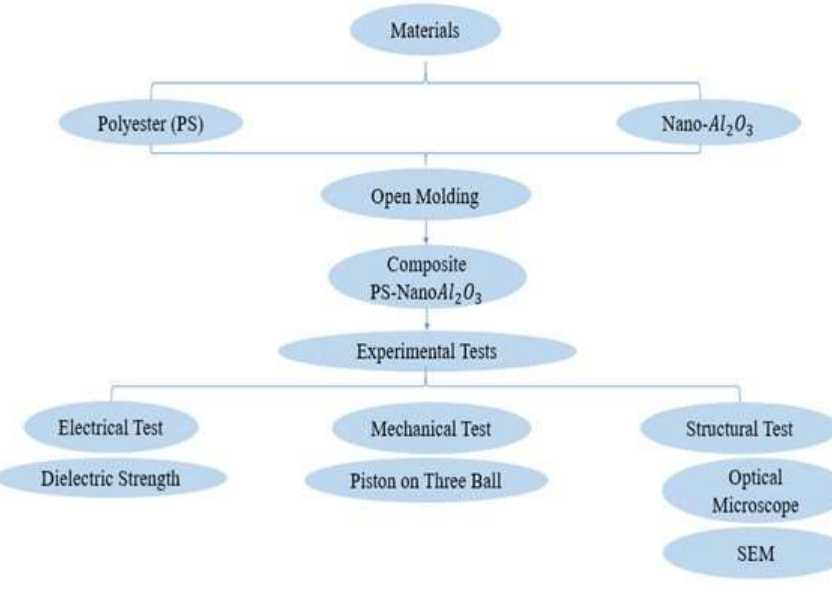
Figure 2: Methodology of